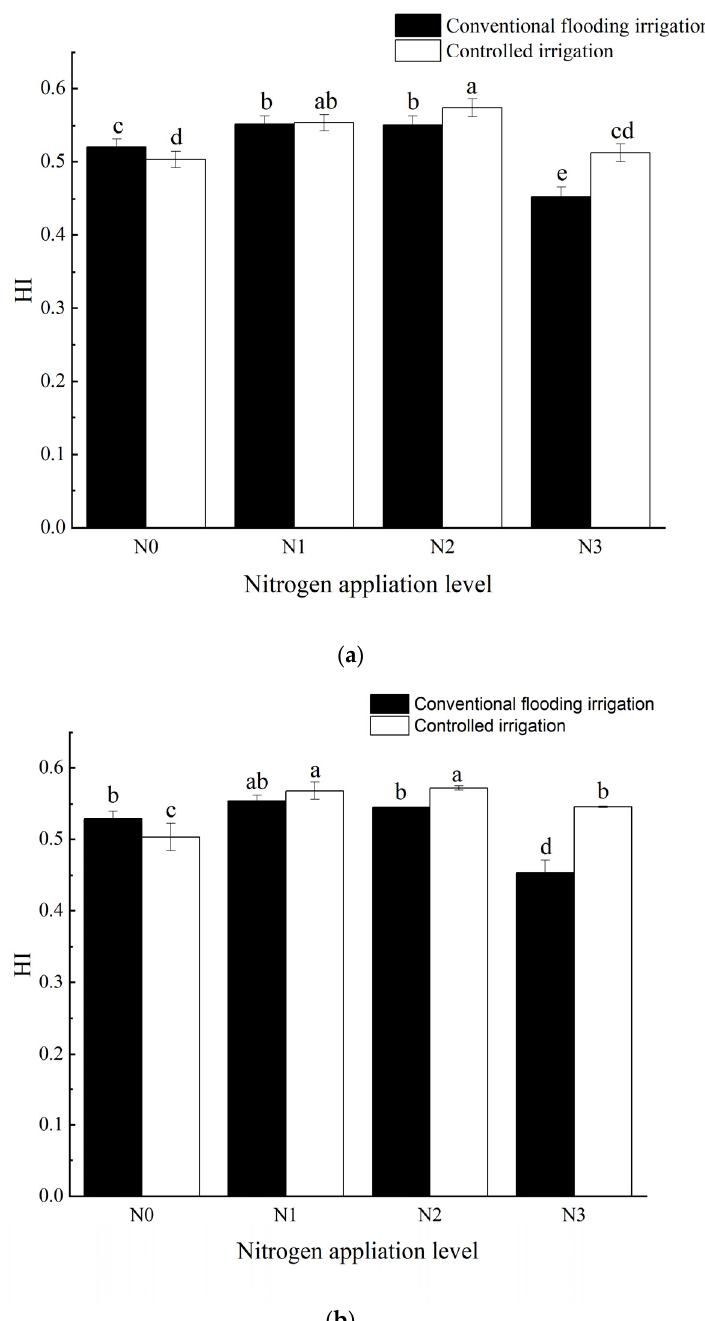
Figure 2. Comparison of the HI under the different irrigation modes in ( a ) 2019 and ( b ) 2020. Note: the different letters in the same figure indicate that the difference between treatments was significant ( p < 0.05), and the same letter indicates that the difference was not significant ( p > 0.05), same as below. Under FI, the order of the rice HI from high to low was FN1 > FN2 > FN0 > FN3. In Y1 and Y2, the HI of the FN1 treatment was the highest; it was 0.552 and 0.554 in two years, respectively, and 0.2%, 6.2%, and 21.9% higher than those of the other three treatments in Y1 and 1.7%, 4.9%, and 22% higher than those of Y2. The difference between FN1 and FN2 was not significant in the two-year experiment ( p > 0.05), and the difference between FN2 and FN0 reached a significant level in Y1 ( p < 0.05). There was no significant difference between FN2 and FN0 in Y2, and the difference between FN0 and FN3 reached a significant level in two years ( p < 0.05). Under CI, the order of HI from high to low was: CN2 > CN1 > CN3 > CN0. In Y1 and Y2, the HI of the CN2 treatment was the highest, respectively, 3.6%, 12.1%, and 14.1% higher than those of the other three treatments in Y1 and 0.7%, 4.8%, and 13.7% higher than those of Y2. The HIs of the CN2 and CN1 treat ‐ ments were different but not significant ( p > 0.05). The difference in the HIs between the CN1 and CN3 treatments reached a significant level in two years ( p < 0.05), and the differ ‐ ence in the HIs between the CN3 and CN0 treatments was not significant in Y1 but signif ‐ icant in Y2 ( p < 0.05). Although the significant difference level in the experiment was dif ‐ ferent in the interannual variation, under the same irrigation mode, the HI first increased and then decreased with an increase in the nitrogen application. In this experiment, the change trend of the HI under CI was similar to that of the yield, but not under FI because, under FI, with an increase in the nitrogen application, the increase rate of the dry matter accumulation was greater than that of the yield, resulting in a decline in the rice HI. The data showed that different water and nitrogen management modes will affect the rice HI, and, for improving the rice HI, CI was better than FI, and N1 and N2 show advantages in improving the rice HI.